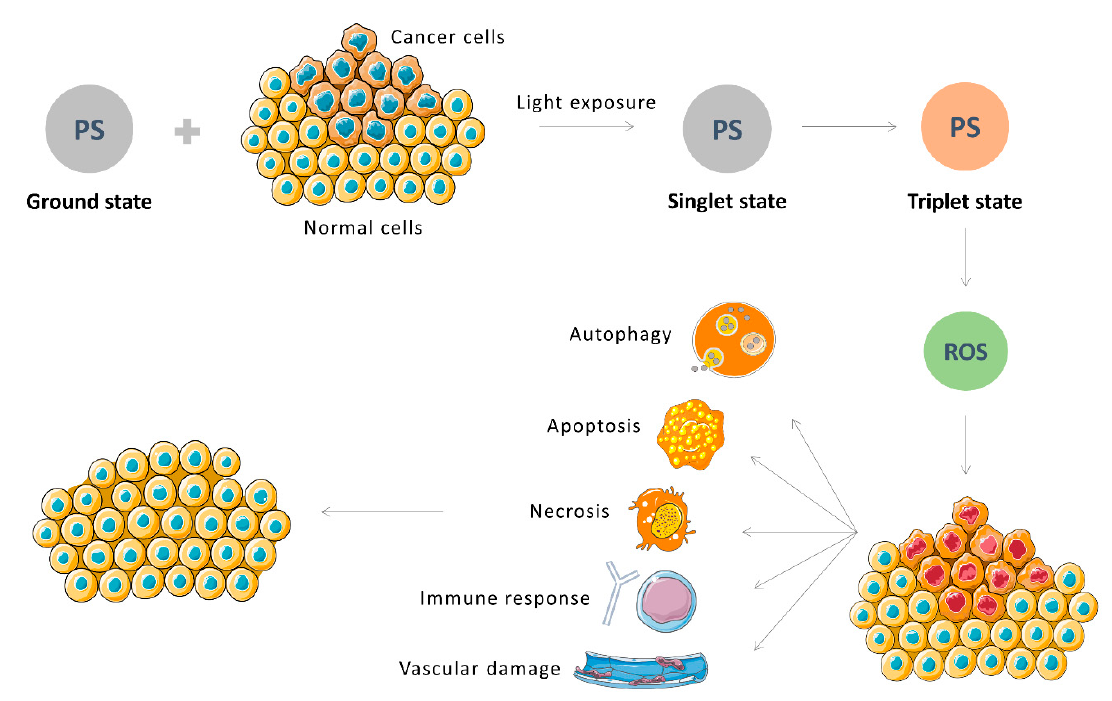
Figure 1. Photodynamic therapy (PDT) for cancer treatment.